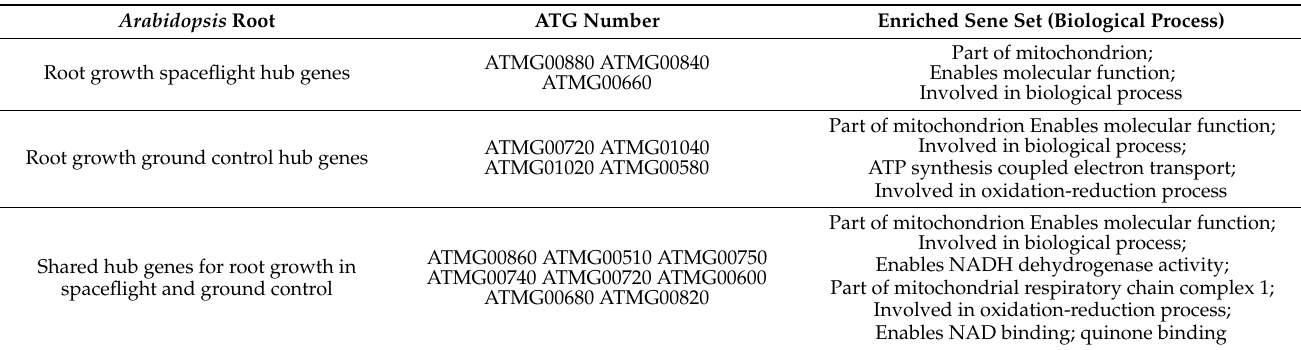
Table 2. Hub genes from the Pearson Correlation GRN and HITS method and shared hub genes for GLDS 7 for Arabidopsis thaliana root growth in spaceflight and ground control with their gene